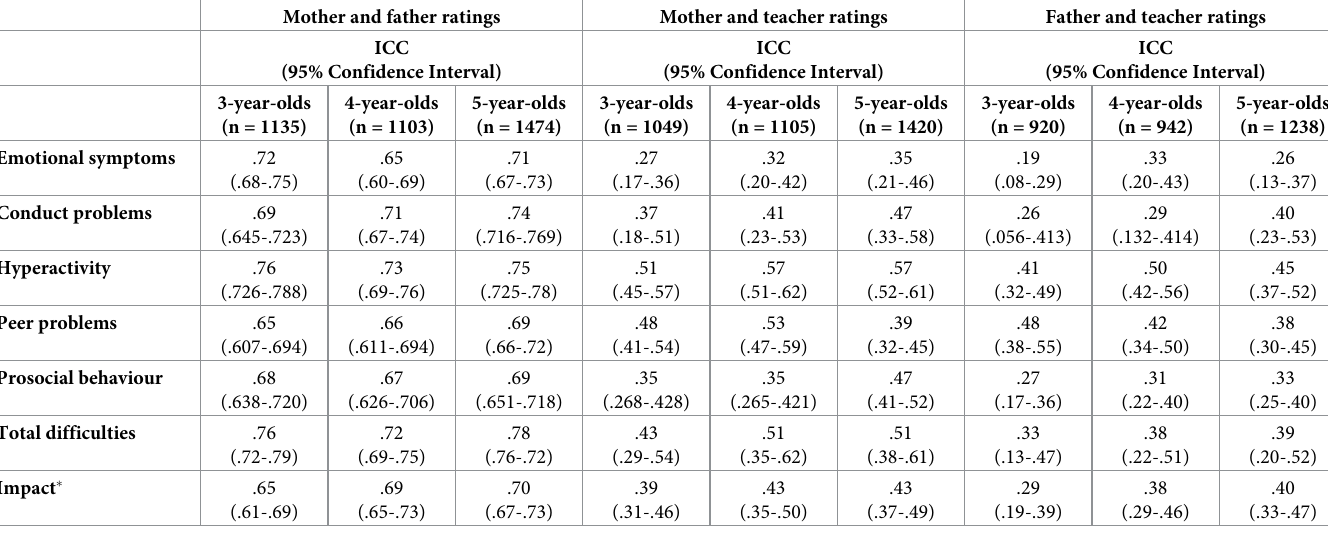
Table 6. Inter-rater agreement for SDQ scores by child